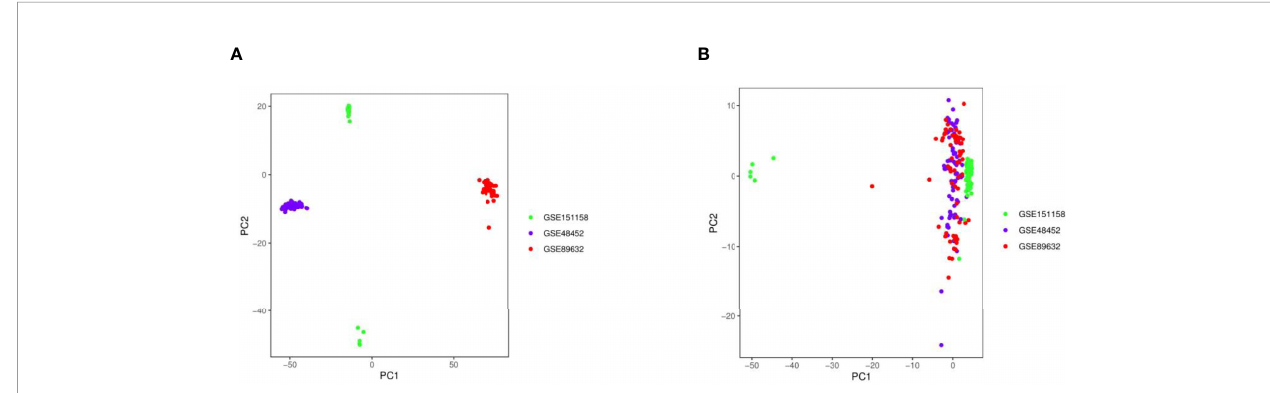
FIGURE 2 | Principal component analysis (PCA) plots with or without the elimination of batch effects. (A) PCA plot without batch effect elimination; (B) PCA plot with batch effect elimination.